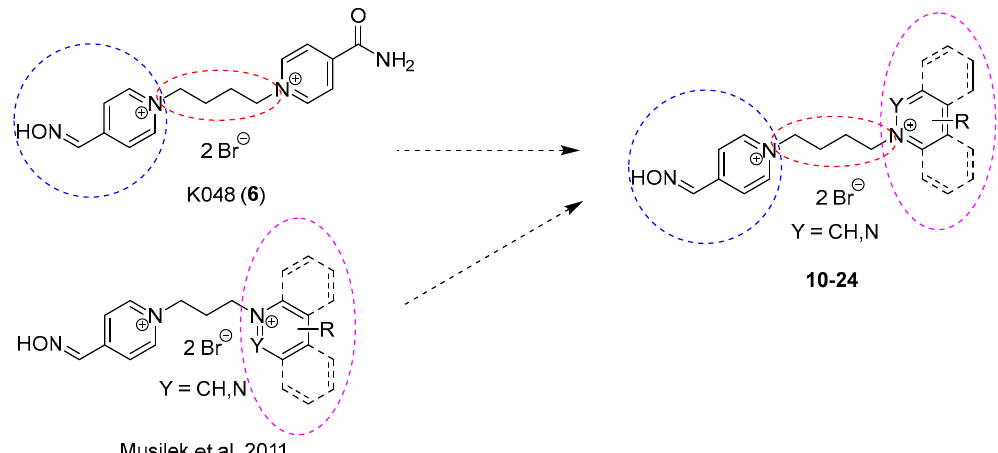
Figure 4. Design of bisquaternary mono-oxime reactivators with but-1,4-diyl linkage.